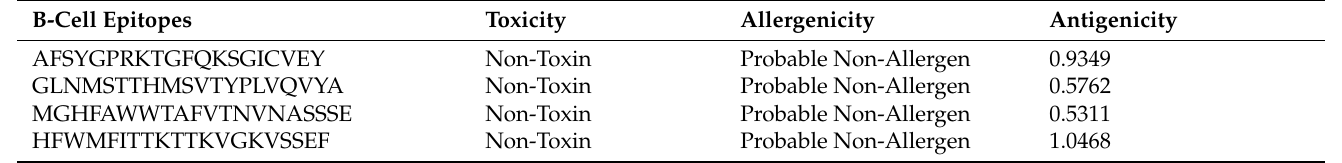
Table 3. The B cell epitopes selected after screening for toxicity, allergenicity, and antigenicity predictions. B-Cell